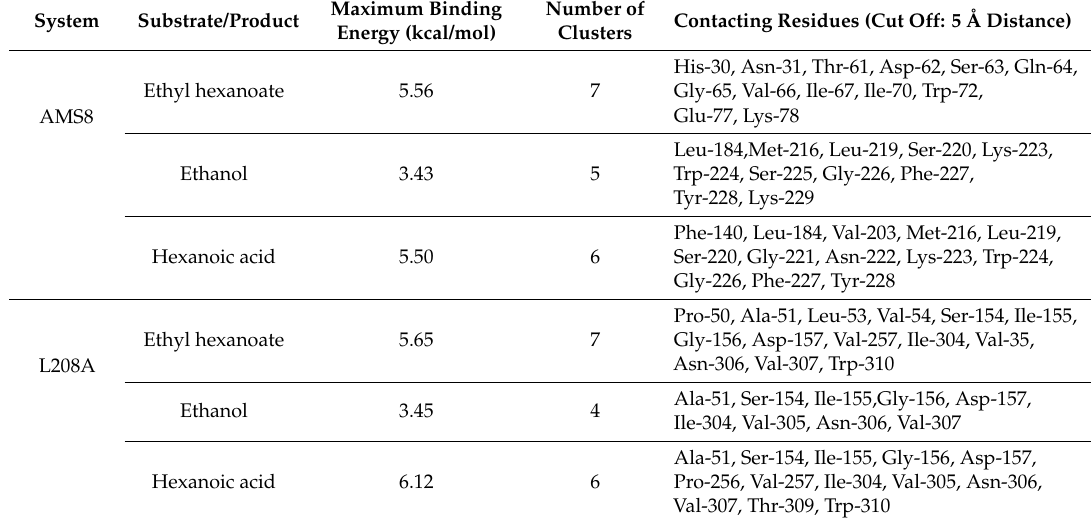
Table 2. A comparison of binding energy and number of clusters between AMS8 lipase and mutant L208A in complex system of